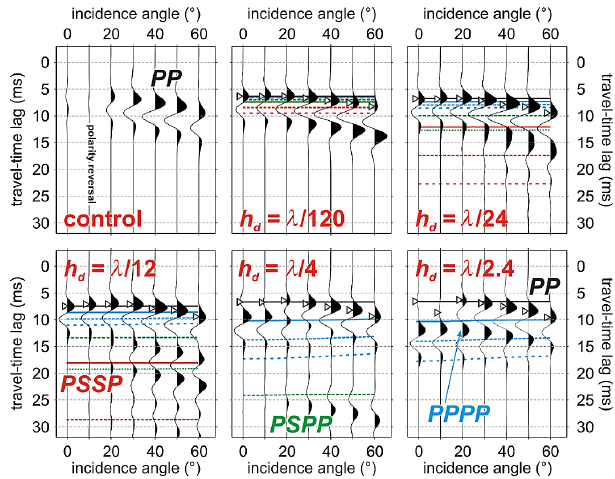
Fig. 4. Synthetic seismic responses to thin layers of h d varying from λ /120 and beyond λ /4. Traces are non-stretch NMO corrected, and amplitudes are corrected for attenuation losses and geometric spreading. Coloured lines are the ray-traced travel-times, with the equivalent colour and line-style conventions as in Fig. 3. The con- trol response shows the reflection from ice overlying a dilatant till half-space. Grey triangles show the location of amplitude picks used to generate AVA curves in Fig.